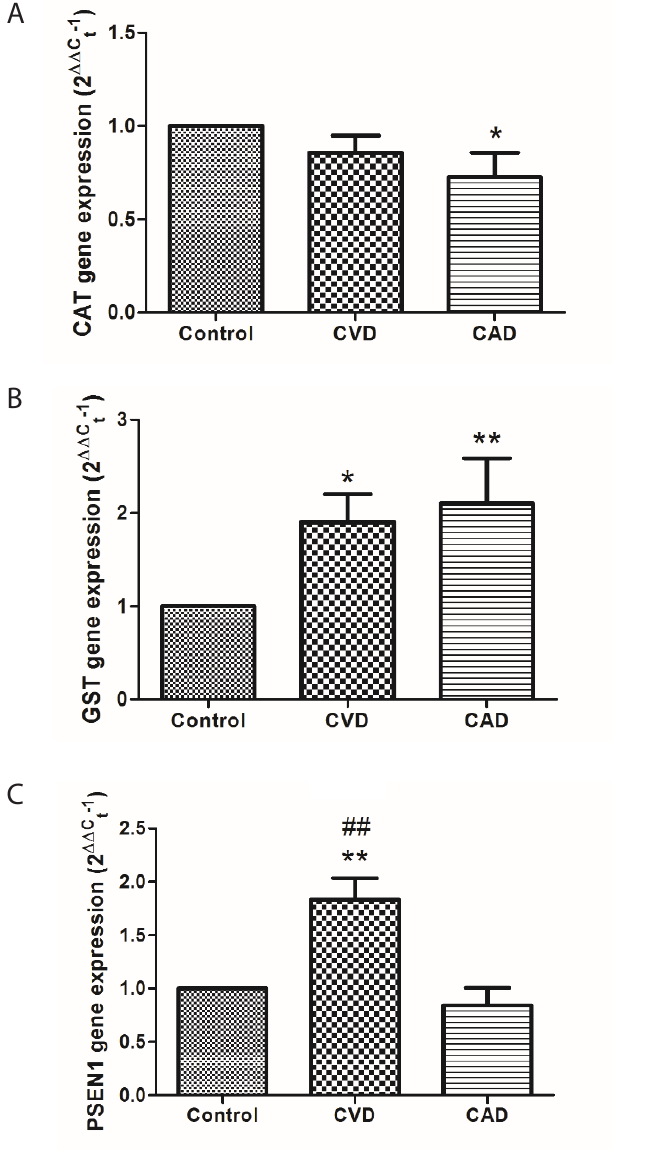
Fig. 3 - CAT (a), GST (b) and PSEN (d) enzyme activity levels in plasma and GST (c) enzyme activity in erythrocytes for all groups (patients with CVD and CAD and controls). The symbols denote significant differences from the control group at (**) P<0.01 and (***) P<0.001 from the CAD group at (#) P<0.05 by using one-way ANOVA with LSD (least significant difference) post hoc test